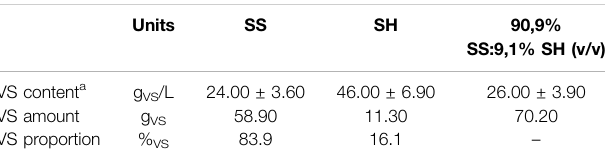
TABLE 3 | Operating parameters of the AcoD ef fi ciency test.